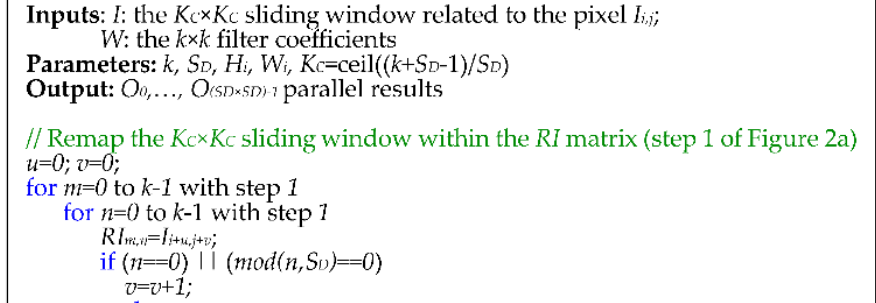
Figure A1 details how the proposed approach processes the generic K C × K C sliding window with the pixel I i , j in the top-left position.